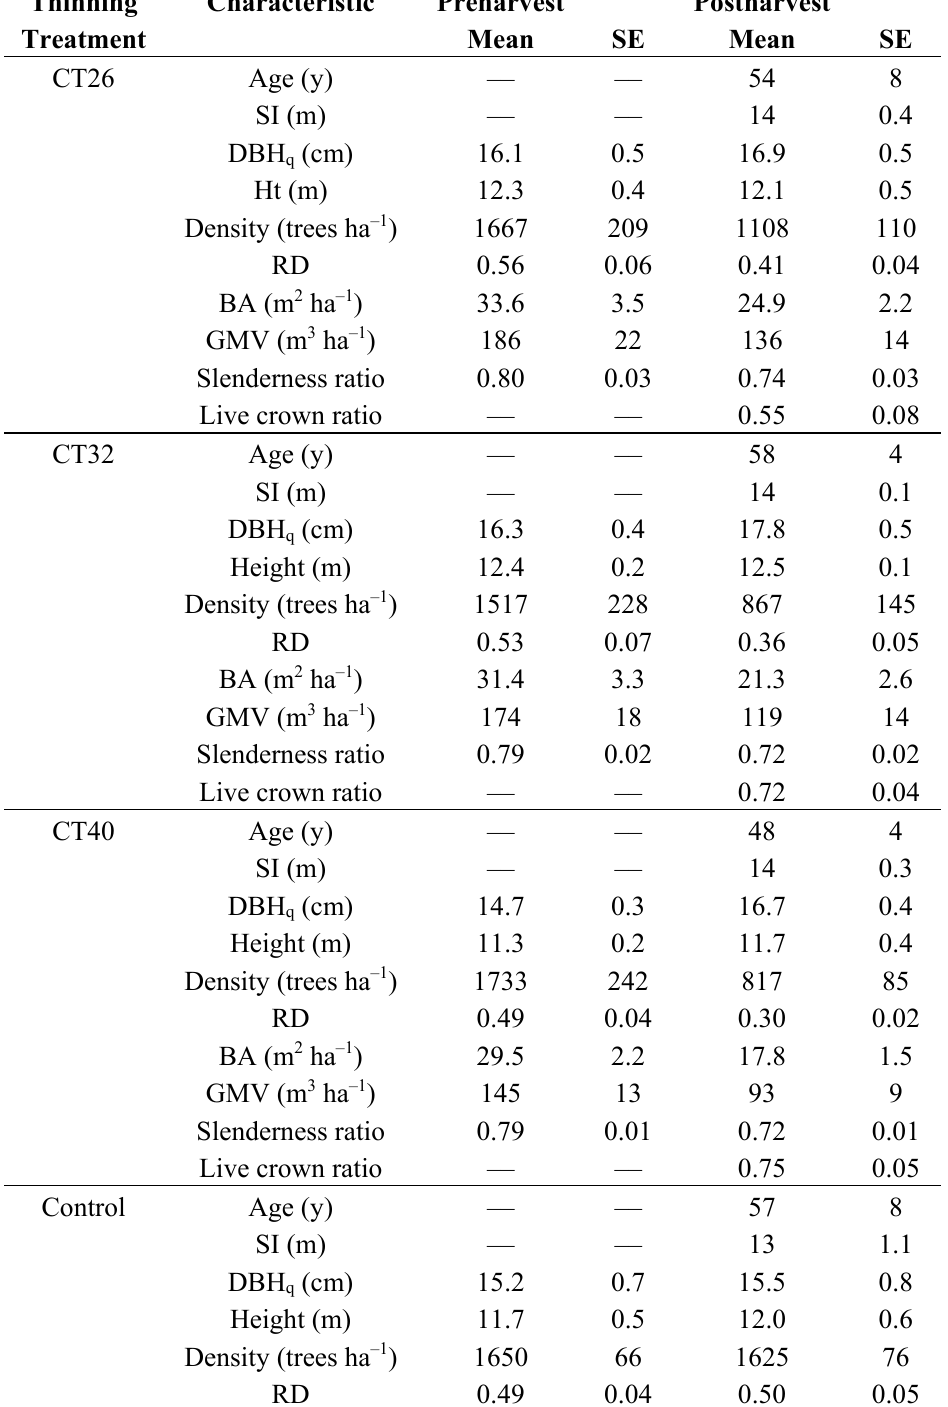
Table 1. Pre- and post-harvest characteristics (mean ± SE) by commercial thinning (CT) intensity (0%, 26%, 32% and 40% merchantable basal area removals). Abbreviations: age, age at 1 m in height; BA, basal area; DBHq, mean quadratic diameter at breast height (DBH) of merchantable trees; GMV, gross merchantable volume; Ht, estimated height of all trees; live crown ratio, crown length/total height of study trees; RD, relative density; SI, mean site index of all species at age 50 at 1-m height; slenderness, ratio of estimated height/DBH. Data not measured prior to thinning are represented by a dashed line